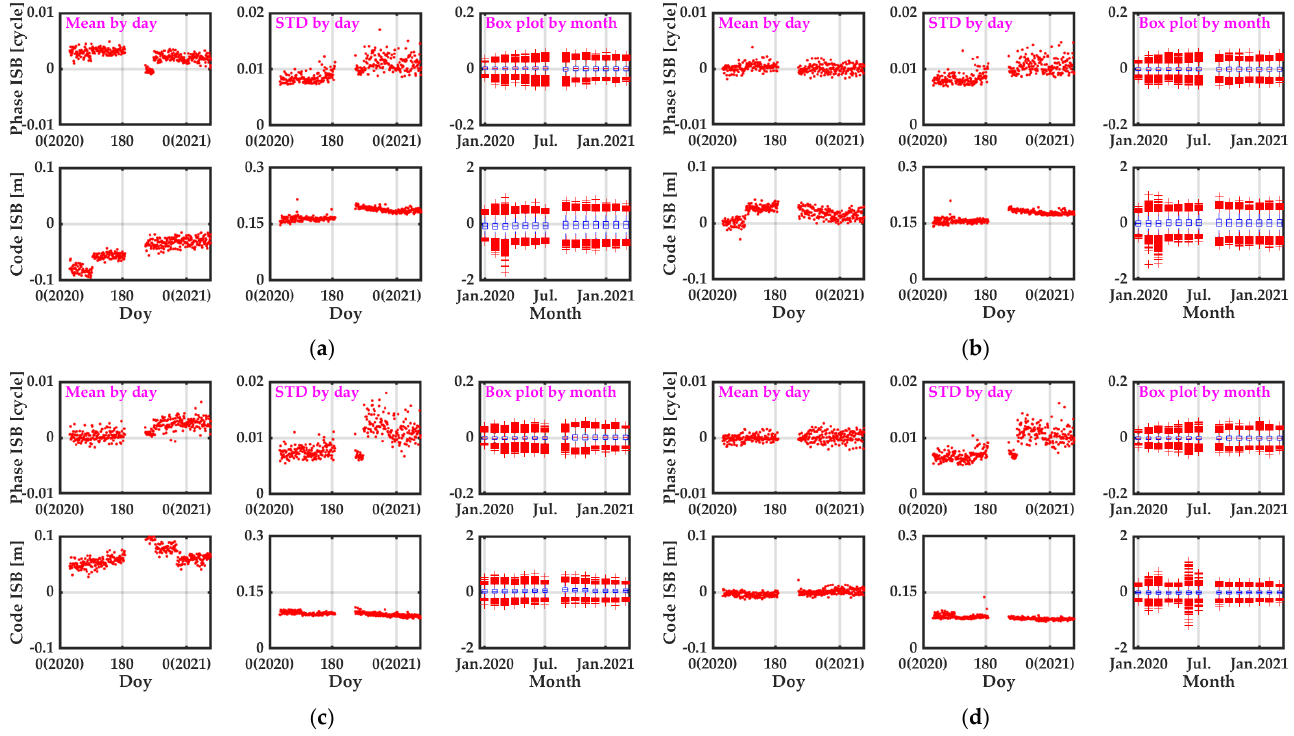
Figure 6. Means for one day, STD for one day, and box plot for one month of both phase and code ISBs between B1C/L1 ( a ),